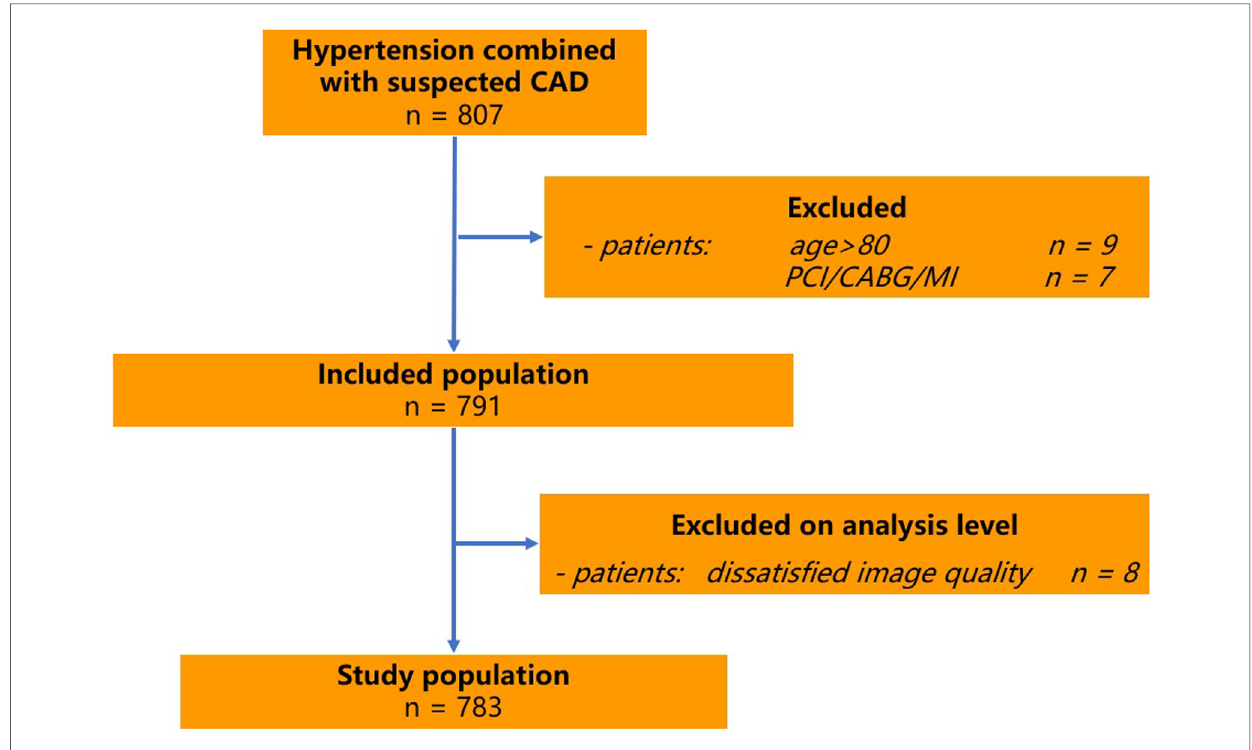
FIGURE 1 Protocol of